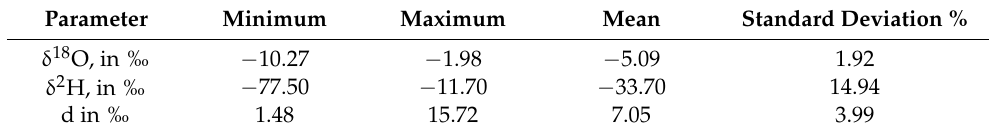
Table 4. Statistical parameters of the isotopic composition of the rainfall in the Ziz